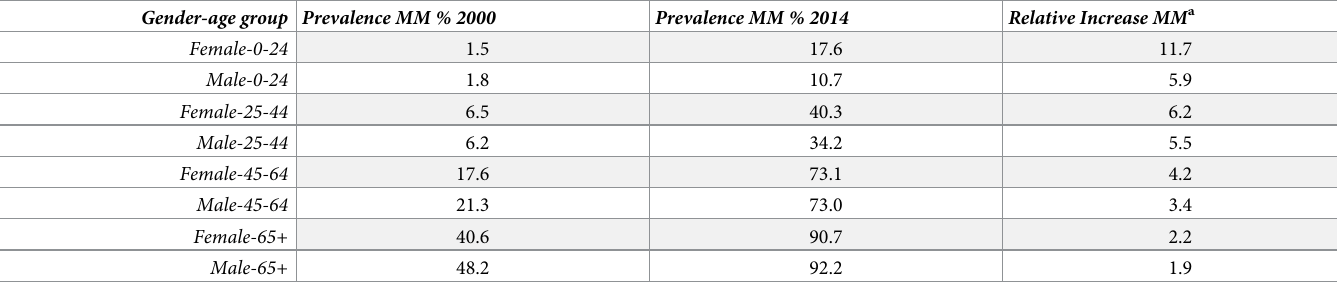
Table 3. Prevalence in terms of the crude incidence proportion of multimorbidity (%) and its relative increase (ratio of prevalence in 2014 versus